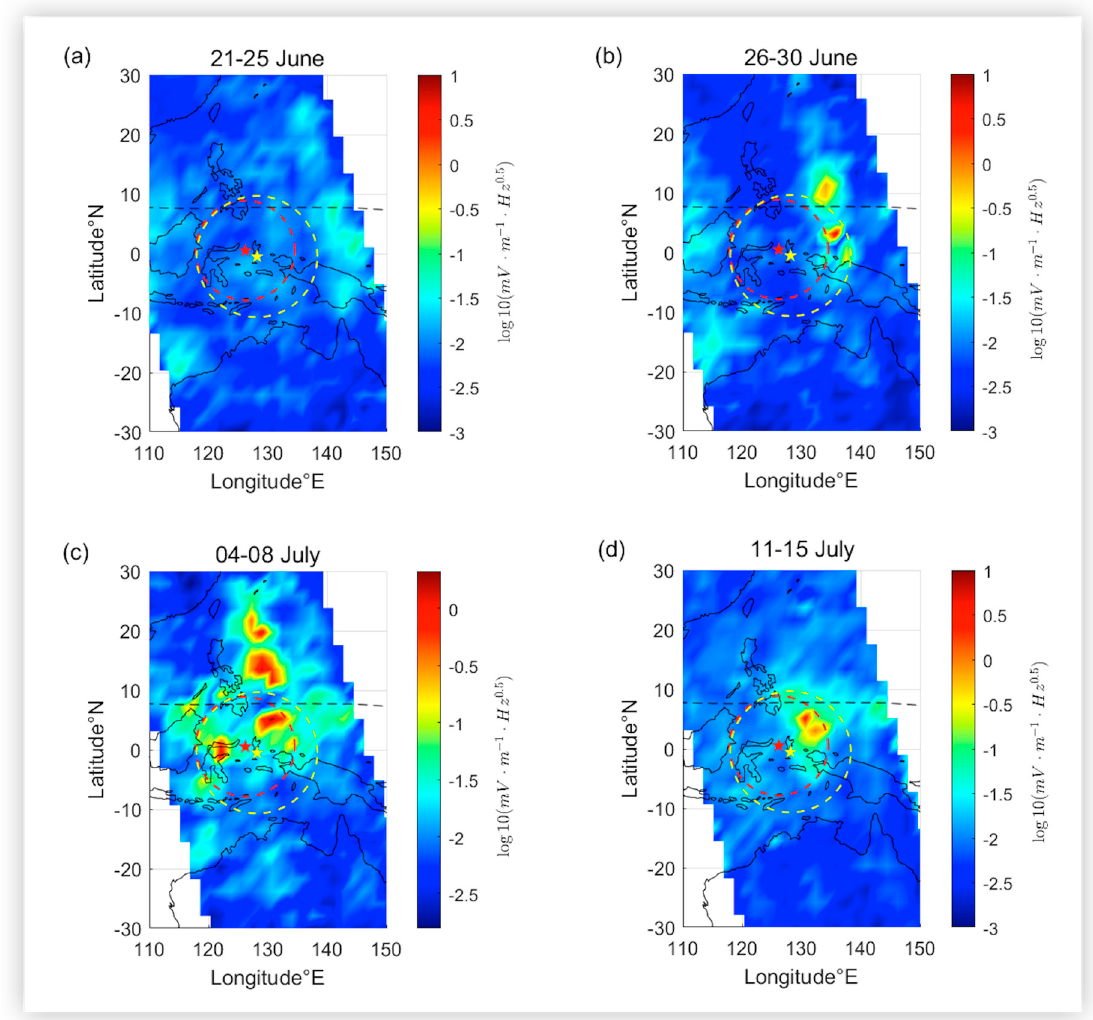
Figure 6. The two-dimensional distribution map for the PSD of the electric field at frequency 48 Hz. The results during the period: ( a ) from 21 to 25 June, ( b ) from 26 to 30 June, ( c ) from 4 to 8 July and ( d ) from 11 to 15 July, respectively. The red (yellow) stars and dashed circles indicate the epicenters and estimated seismogenic zones of earthquake No. 1 (No. 2), respectively. The black dashed curves illustrate the magnetic equators.